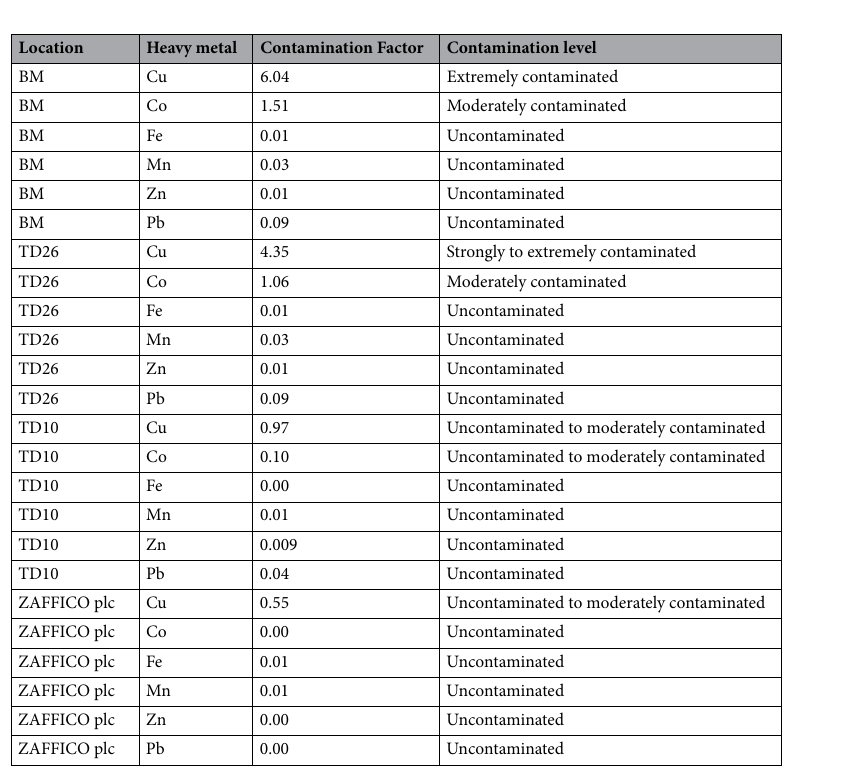
Table 4. Average contamination factor and contamination levels in soil